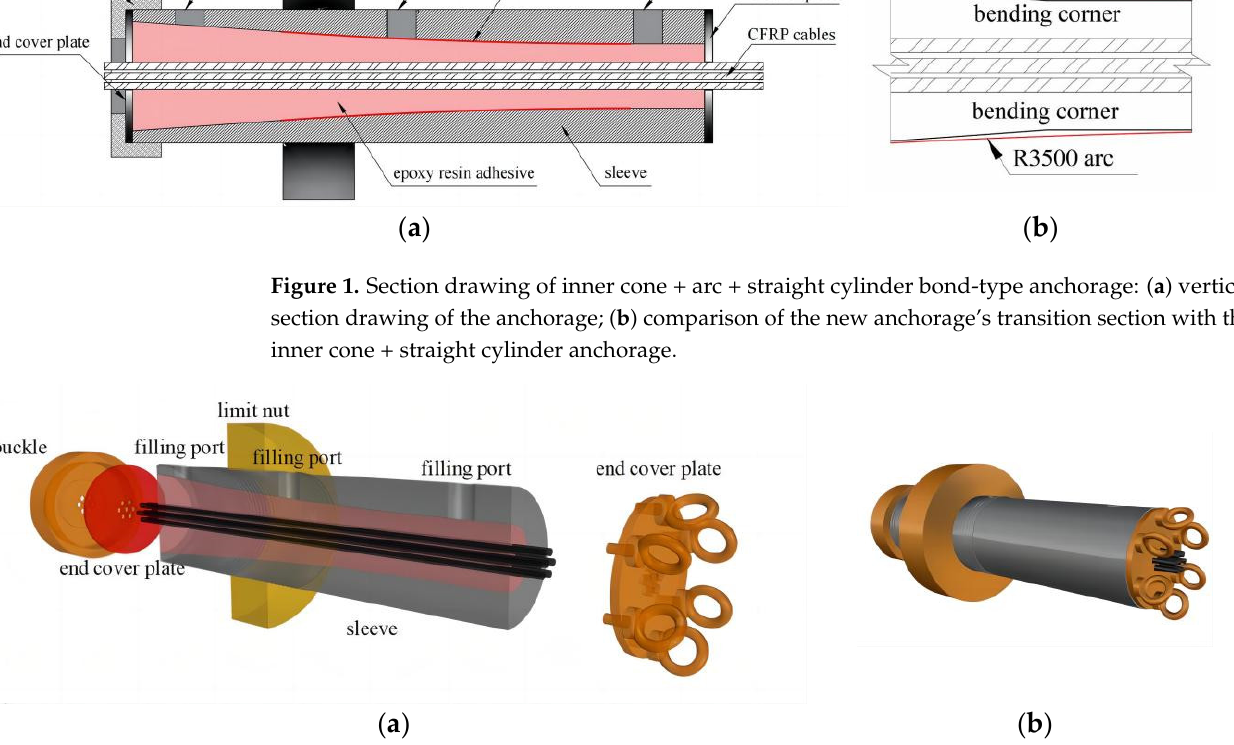
Figure 2. Three-dimensional perspective view of the anchorage: ( a ) internal perspective view; ( b ) external perspective view.